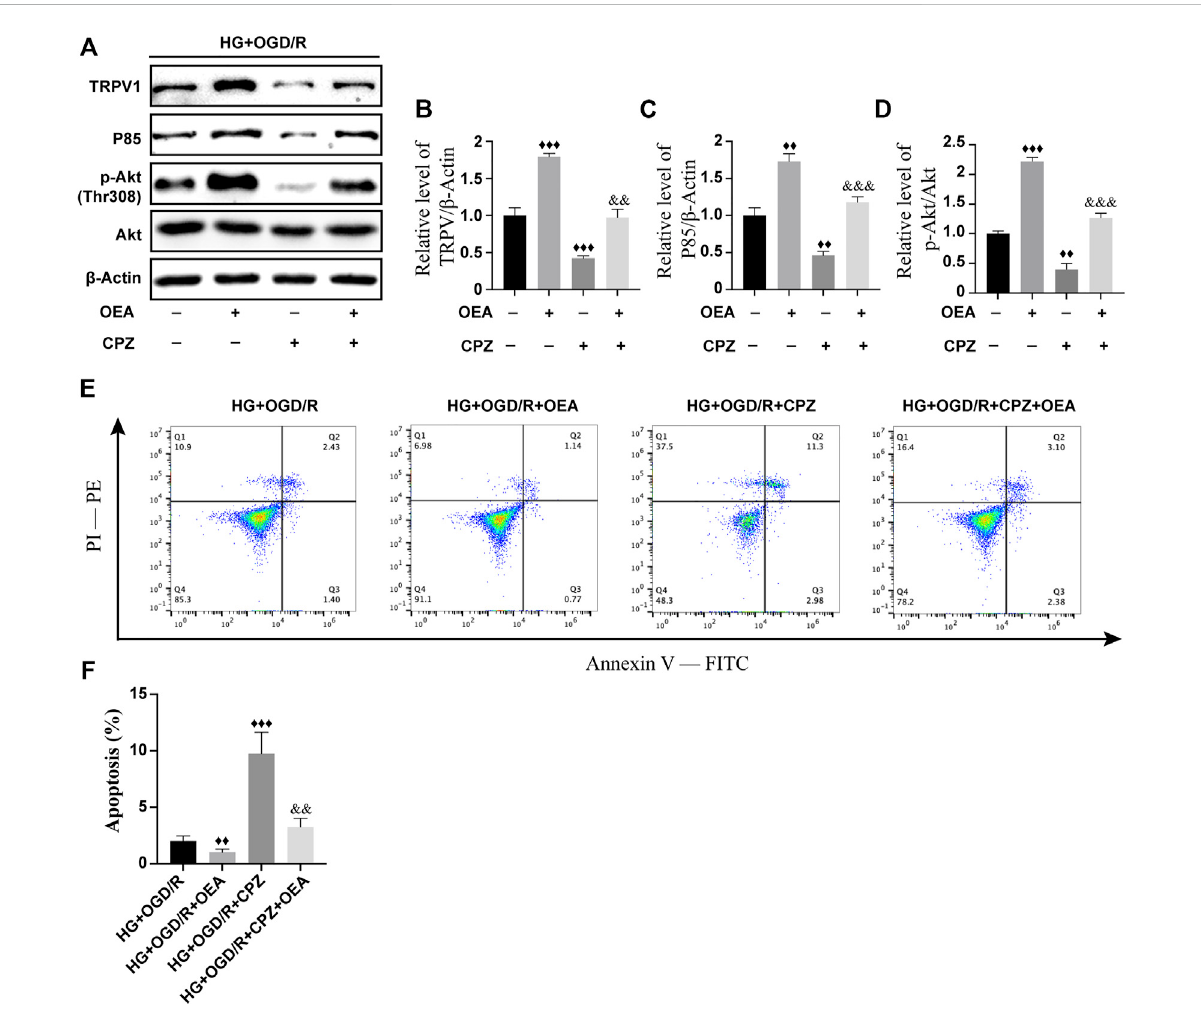
OEA regulated the PI3K/Akt signaling pathway through activation of TRPV1. (A – D) WB results showed the expression levels of TRPV1, P85, and p-AKT in H9C2 cells induced by high glucose and OGD/R and treated with OEA or CPZ. (E) Analysis of cells in each group was performed by fl ow cytometry. Horizontal axis represents Annexin V fl uorescence intensity. Vertical axis represents PI fl uorescence intensity, and Q2 region represents thenumberofapoptoticcells. (F) Statisticalanalysisofapoptoticcellswasperformedby fl owcytometry( n